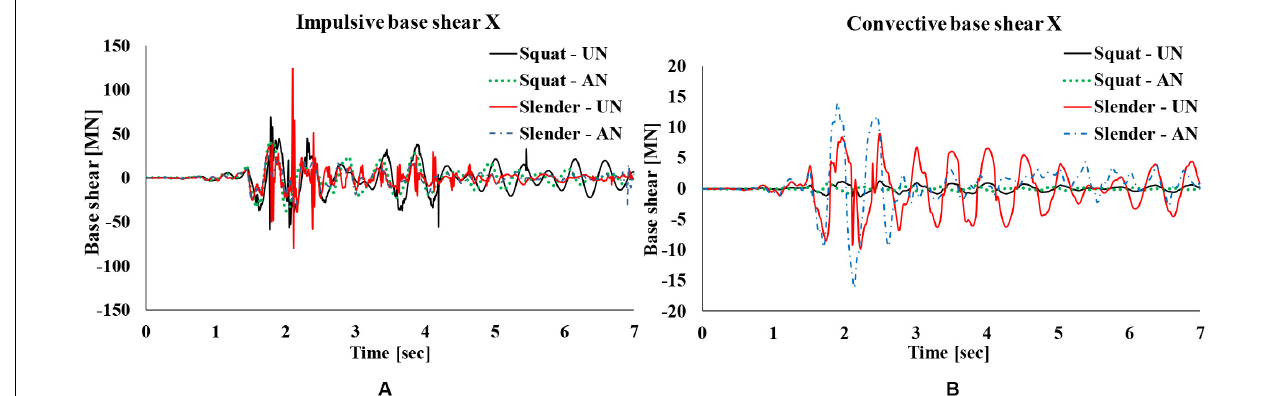
FIGURE 13 | Base shear at X direction for the Northern California record for the anchored and the unanchored ( µ 1 = 0.4) squat tank for soft soil conditions: impulsive (A) and convective (B) components.